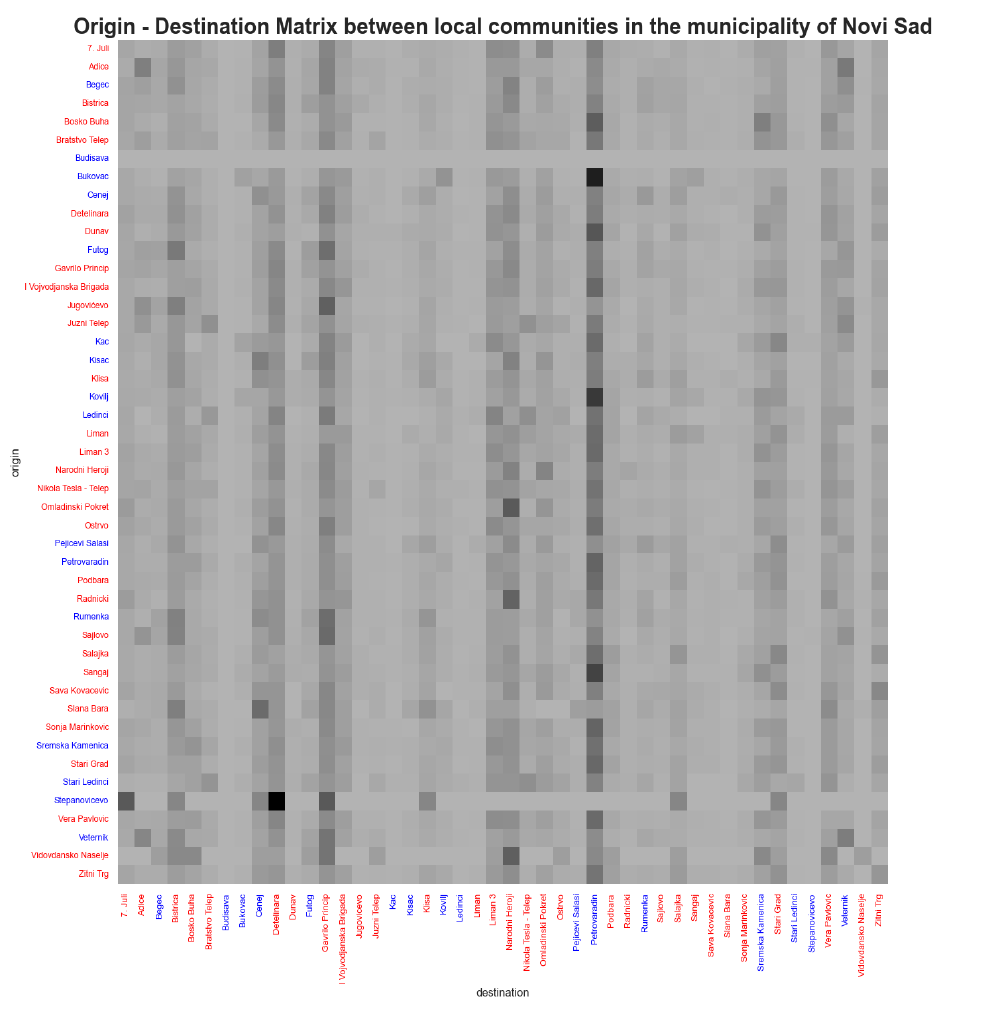
Figure A1. Origin-Destination Probability matrix between local communities in the case study area; red ticks indicate local communities that are in the city area, while the blue ticks represent local communities located outside the